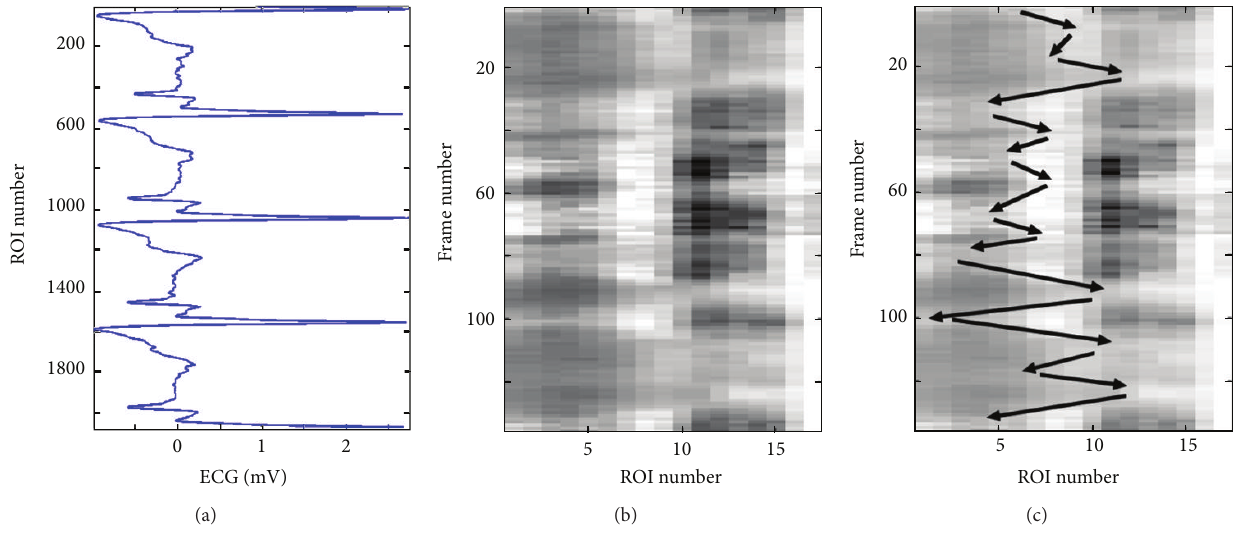
Figure 9: Spatiotemporal wave representation for the pathological case CAD1 (coronary case 1) in Figure 8. The ECG signal is shown to the left (a) and the spatiotemporal 2D map is shown to the right (b). The longitudinal motion, across neighboring ROIs, is marked by black arrows on the spatiotemporal 2D map